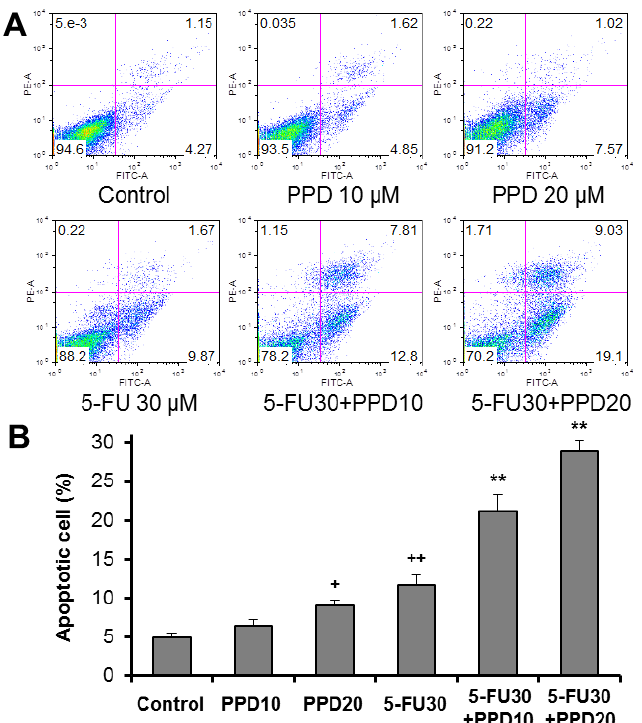
Figure 4. Effects of protopanaxadiol (PPD) on 5-FU-induced apoptosis. HCT-116 human colorectal cancer cells were treated with PPD at various concentrations (10 and 20 µM) in the absence or presence of 5-FU (30 µM) for 48 h. Apoptosis was quantified using annexin V/PI staining followed by flow cytometric analysis. ( A ) Representative scatter plots of PI ( y -axis) vs. annexin V ( x -axis) in each experimental group; ( B ) the percentage of apoptotic cells. Data obtained from triplicate experiments. + p < 0.05; ++ p < 0.01 compared to control; ** p < 0.01 compared to 5-FU